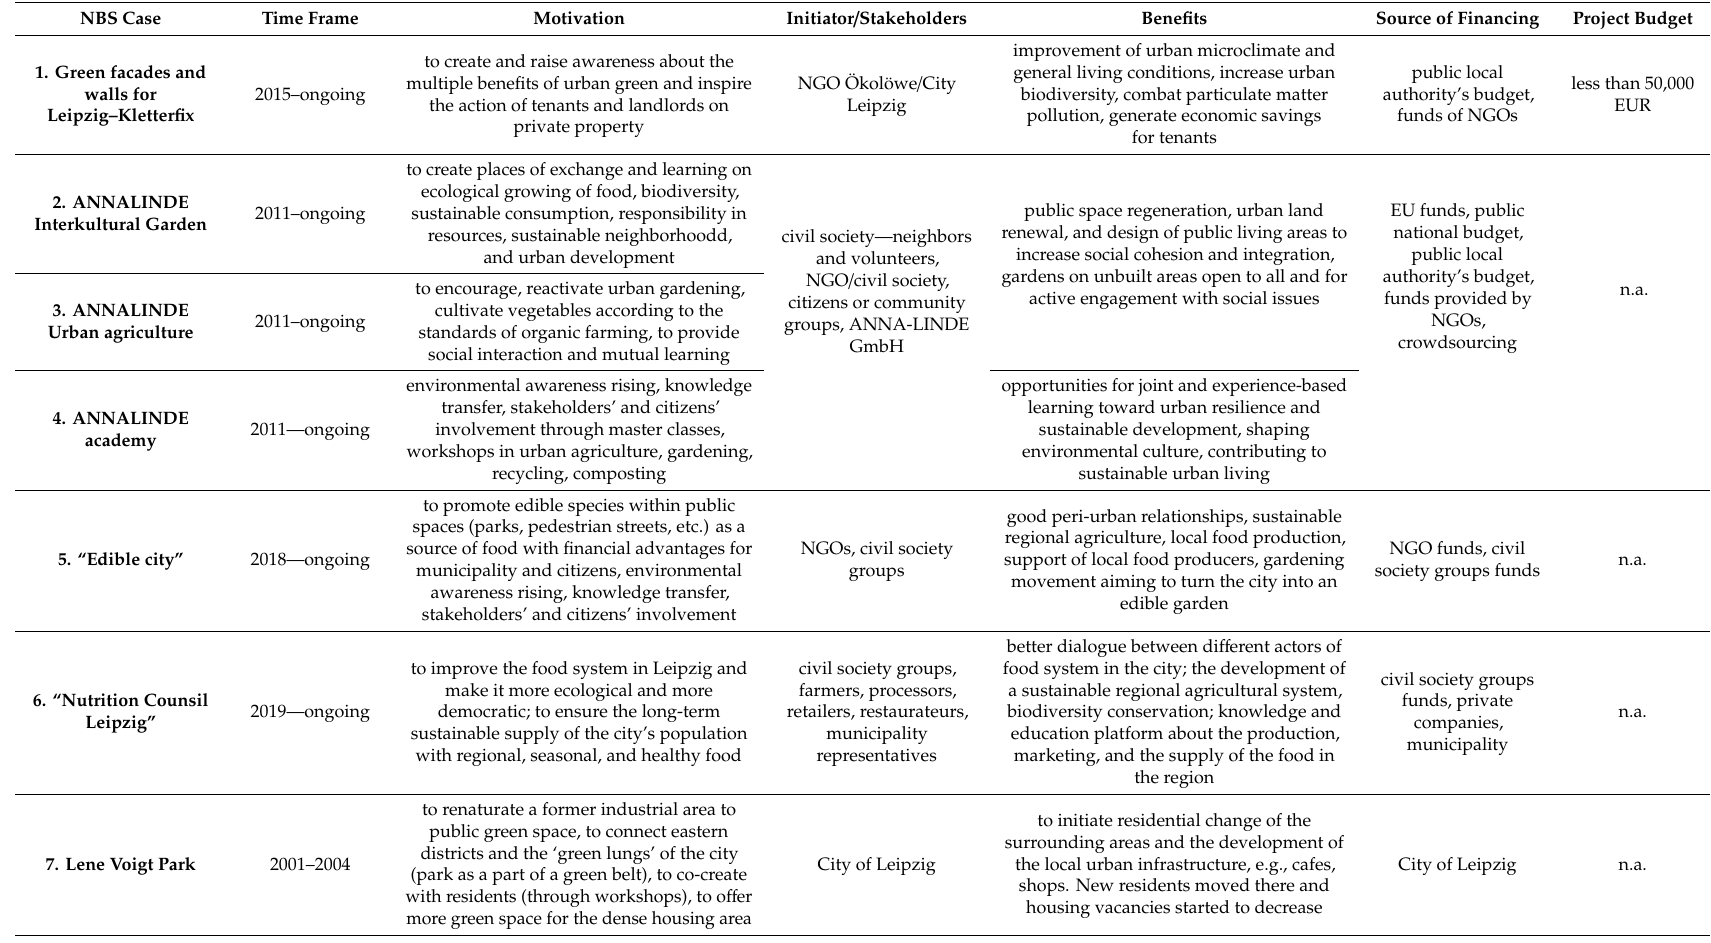
Table 2. Classification of the selected NBS examples in Leipzig. NGOs: nongovernmental